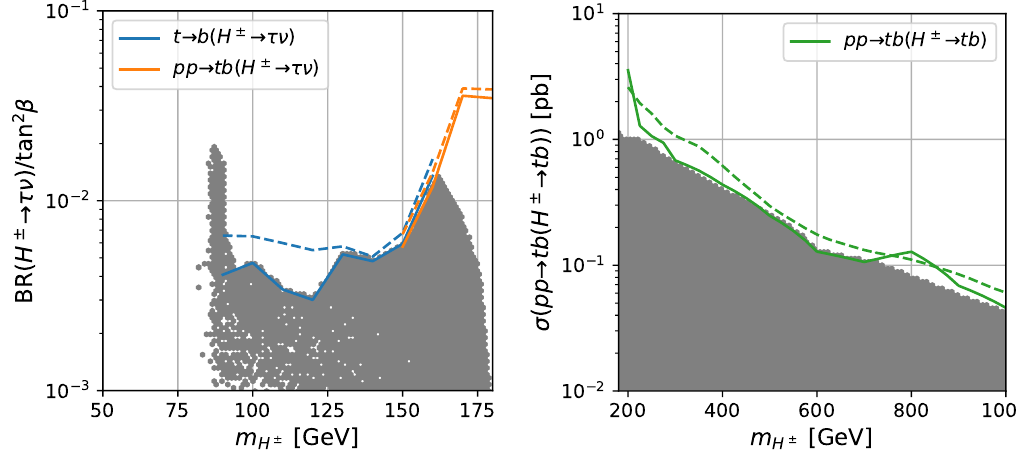
Figure 14. Branching ratio of the charged Higgs boson into τν τ ( left panel , normalized by tan 2 β ), and the 13 TeV LHC signal cross section in the pp → tbH ± , H ± → tb channel ( right panel ) as a function of the charged Higgs boson mass, m . The gray points pass all relevant constraints. In H ± the left plot, we include the observed ( solid line ) and expected ( dashed line ) limits from the most sensitive t → H ± b, H ± → τν ( blue ) and pp → H ± tb, H ± → τν ( orange ) searches [183]. In the τ τ right panel , the limit from the latest pp → H ± tb, H ± → tb search [186] is shown ( green